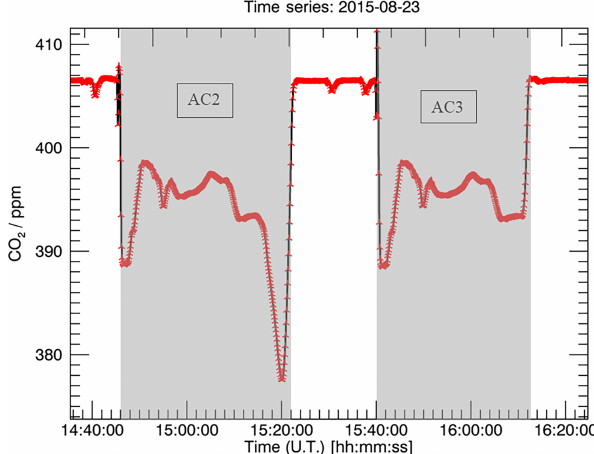
Figure 3. Raw analytical results for CO 2 from the measurements of the two AirCores flown from Timmins in 2015. Note that AC2, which was measured first, contained a closure valve, while AC3 was left open until the recovery team was able to reach the instrument. The lowest part of the AC3 profile was therefore lost due to the warming of the AirCore on the ground. The grey shaded areas de- note the measurements of air from the AirCore. The stratospheric part of the profiles is always measured first. Before the measure- ments of AC2, between the measurements of the AirCores and after the measurement of AC3, PG is measured by the Picarro